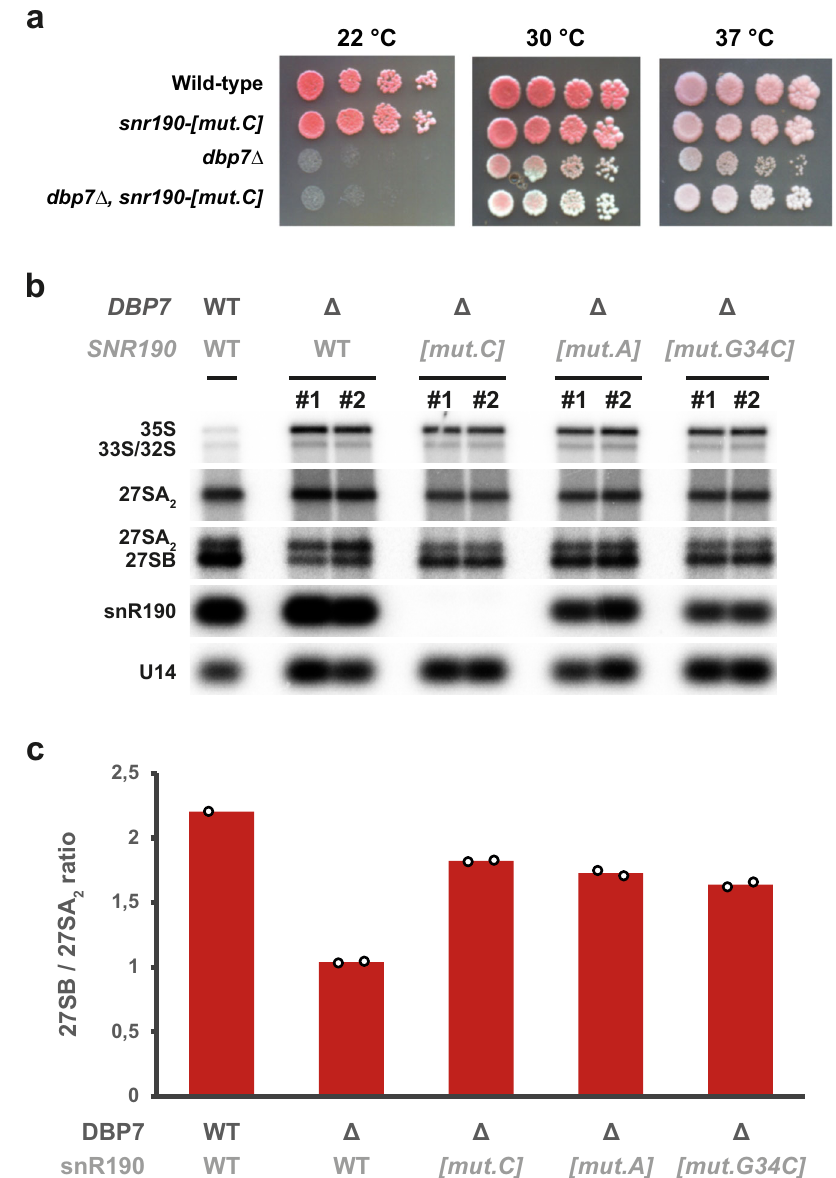
Fig. 7 Mutations in SNR190 alleviate the phenotypes of the dbp7 Δ strain. a Growth assay of isogenic wild-type, single snr190-[mut.C] , single dbp7 Δ and double dbp7 Δ , snr190-[mut.C] mutants in the W303 background. Serial dilutions of these strains were grown on YPD plates at the indicated temperatures for 3 – 5 days. b Accumulation levels of rRNA precursors in the wild-type BY4741 strain or in two independent clones (#1 and #2) of the dbp7 Δ strain and the dbp7 Δ strain further manipulated using the CRISPR-Cas9 approach to deplete snR190 ( snr190-[mut.C] ) or to express snr190-[mut.A] and snr190- [mut.G34C] . Experiments were performed as explained in the legend of Fig. 2b. c Quanti fi cation of the 27SB/27SA 2 ratios for the indicated strains from the precursor levels measured in b using PhosphorImager data and the MultiGauge software. Data correspond to two biological replicates. Histograms represent the mean values. The individual data points are